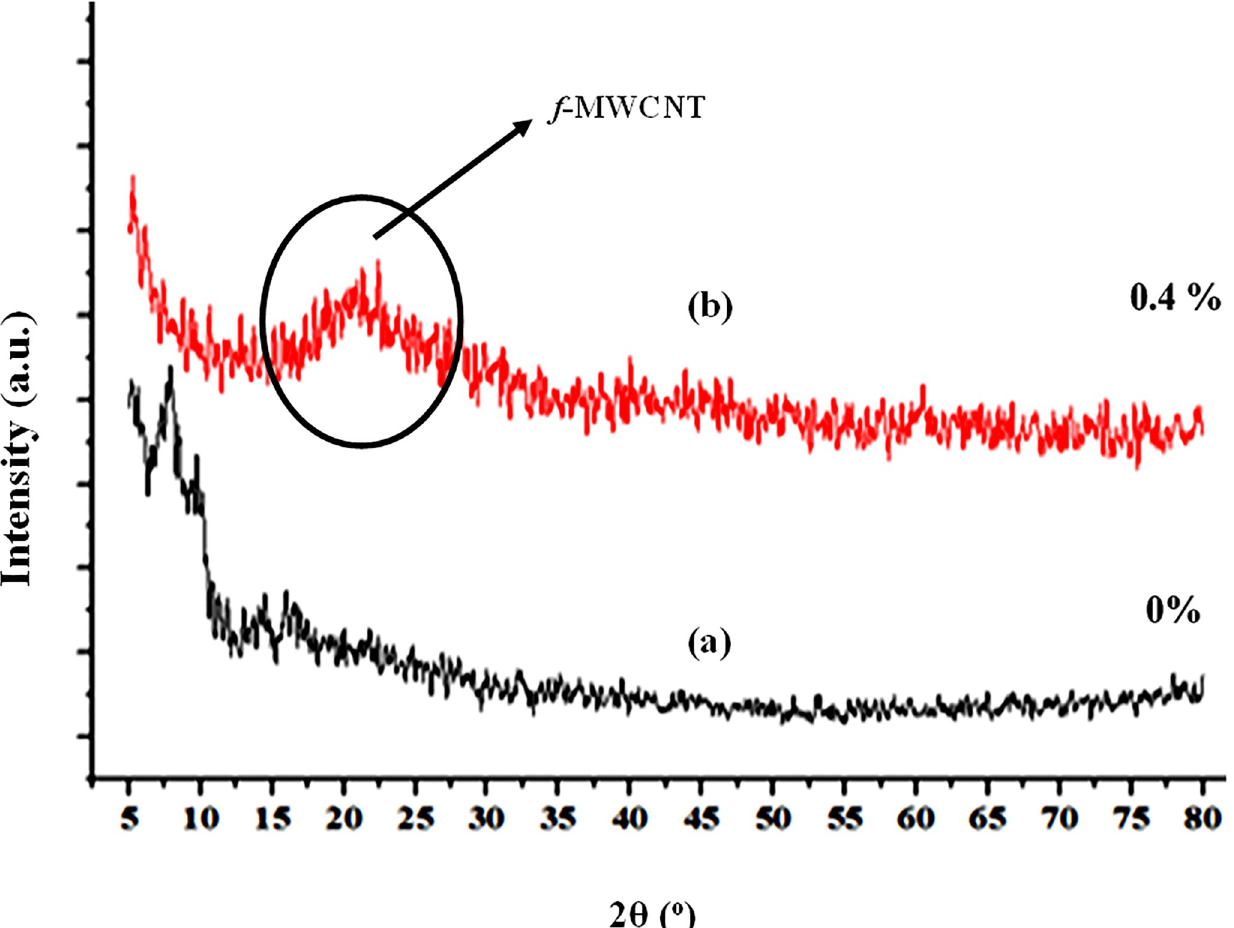
Fig 5. XRD pattern of (a) virgin sample (b) 0.4 wt. % f-MWCNTs glass fiber